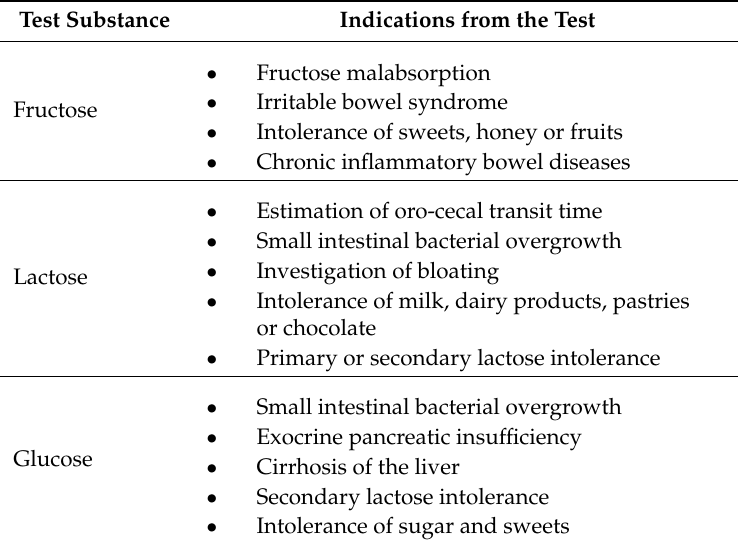
Table 2. Types of hydrogen breath tests and their diagnostic potential